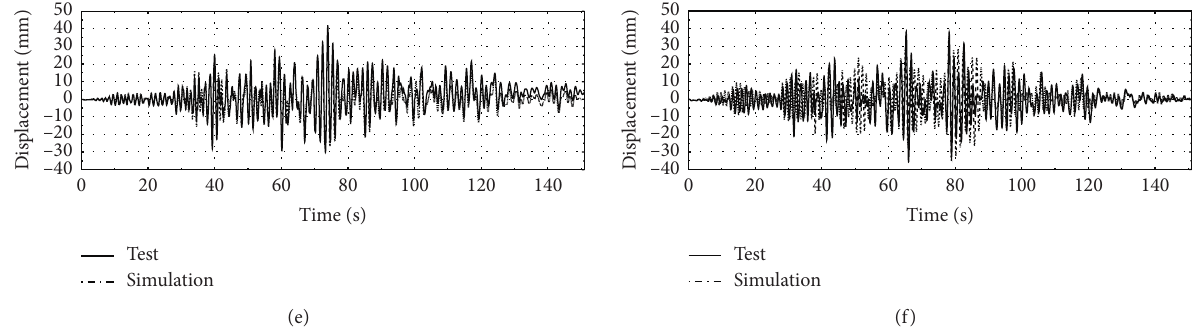
Figure 13: Displacement seismic response contrast between experiments and simulations. (a) Artificial synthetic-condition 1-transverse. (b) Artificial synthetic-condition 2-longitudinal. (c) Imperial Valley-condition 3-transverse. (d) Imperial Valley-condition 4-longitudinal. (e) Alaska-condition 5-transverse. (f) Alaska-condition 6-longitudinal.